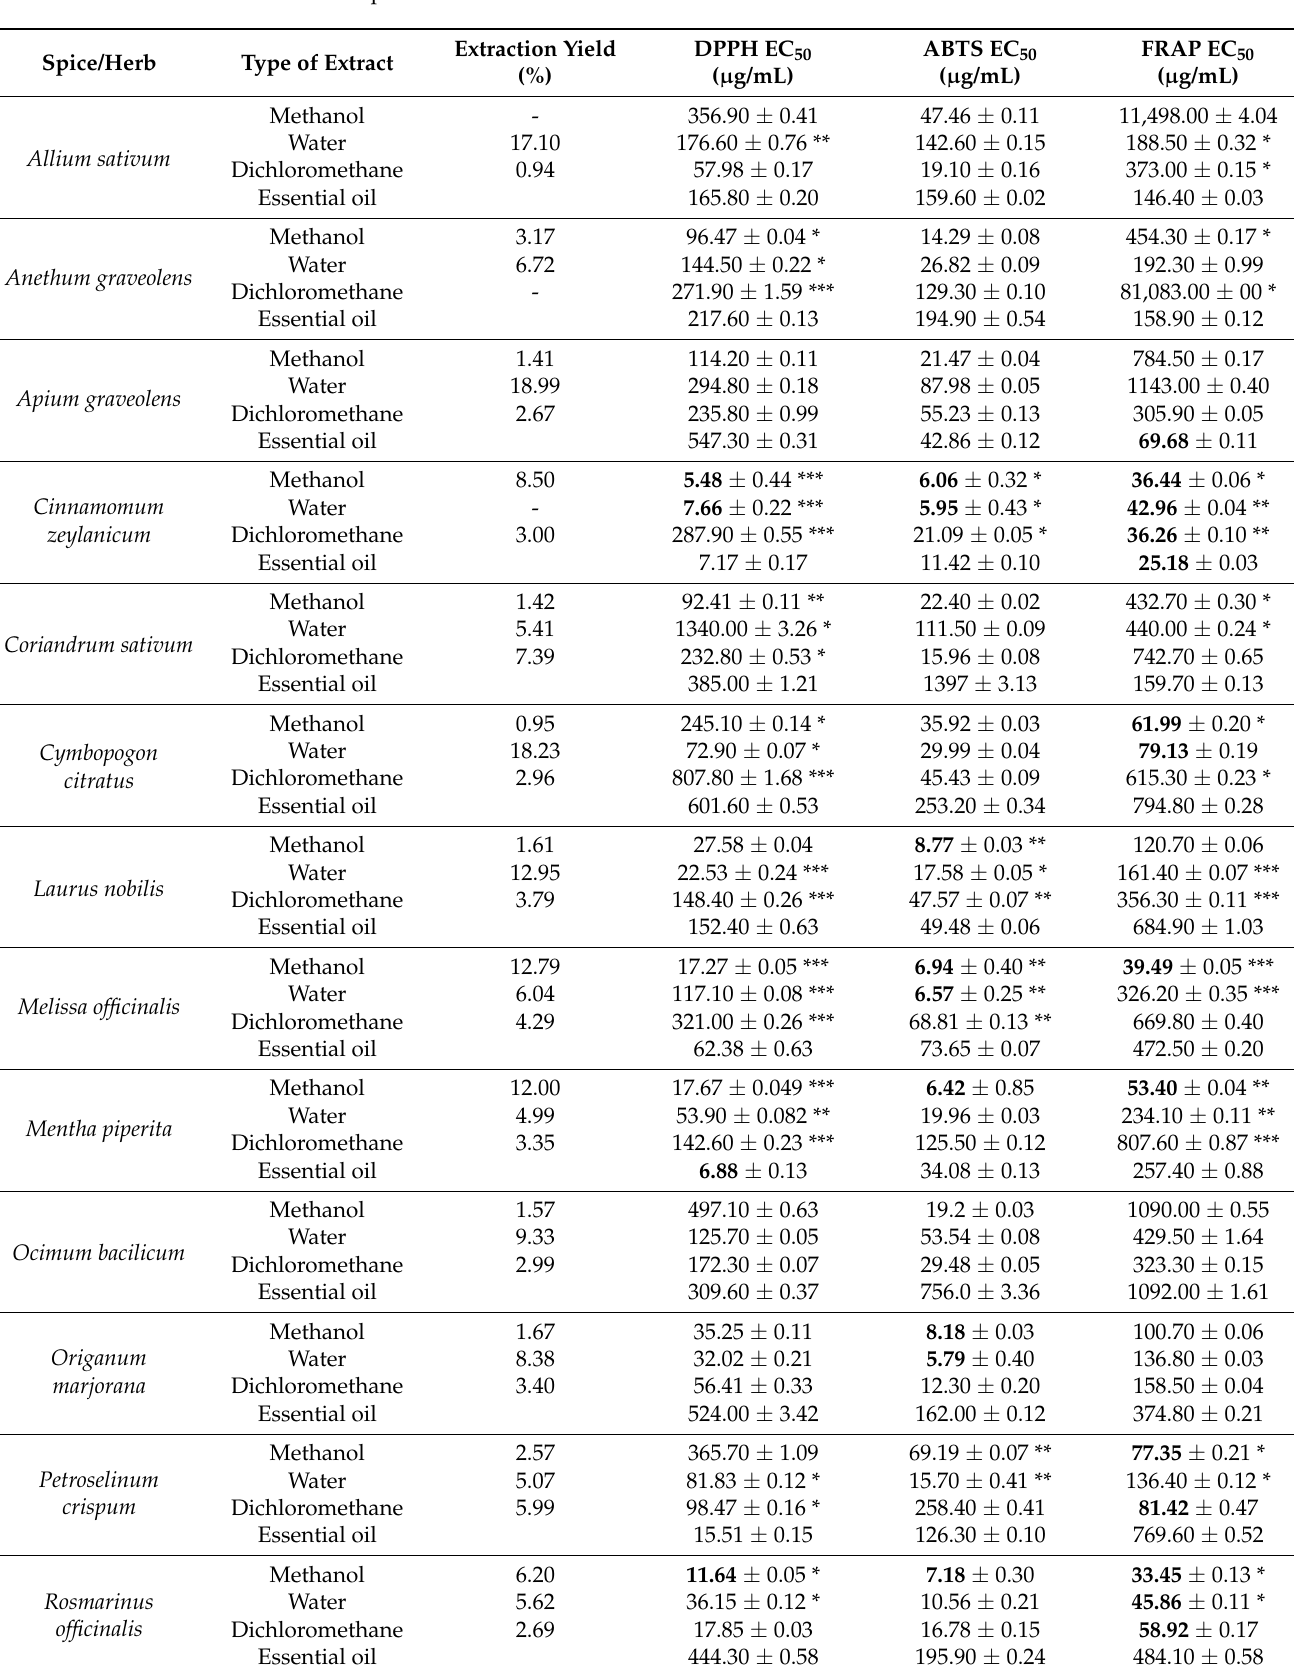
Table 1. Antioxidant activity of crude extracts and essential oils of some common culinary herbs and